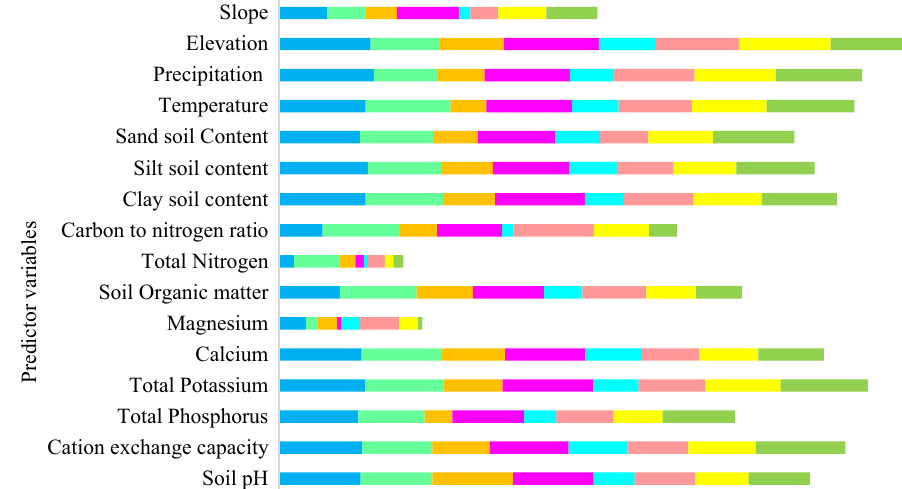
Fig. 2 Strength of the impacts of variables in predicting the log abundances of woody species based on %incMSE values using the RF model